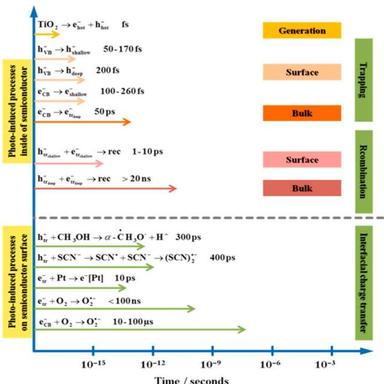
Photo-induced reactions in TiO2 photocatalysis and the corresponding time scales .